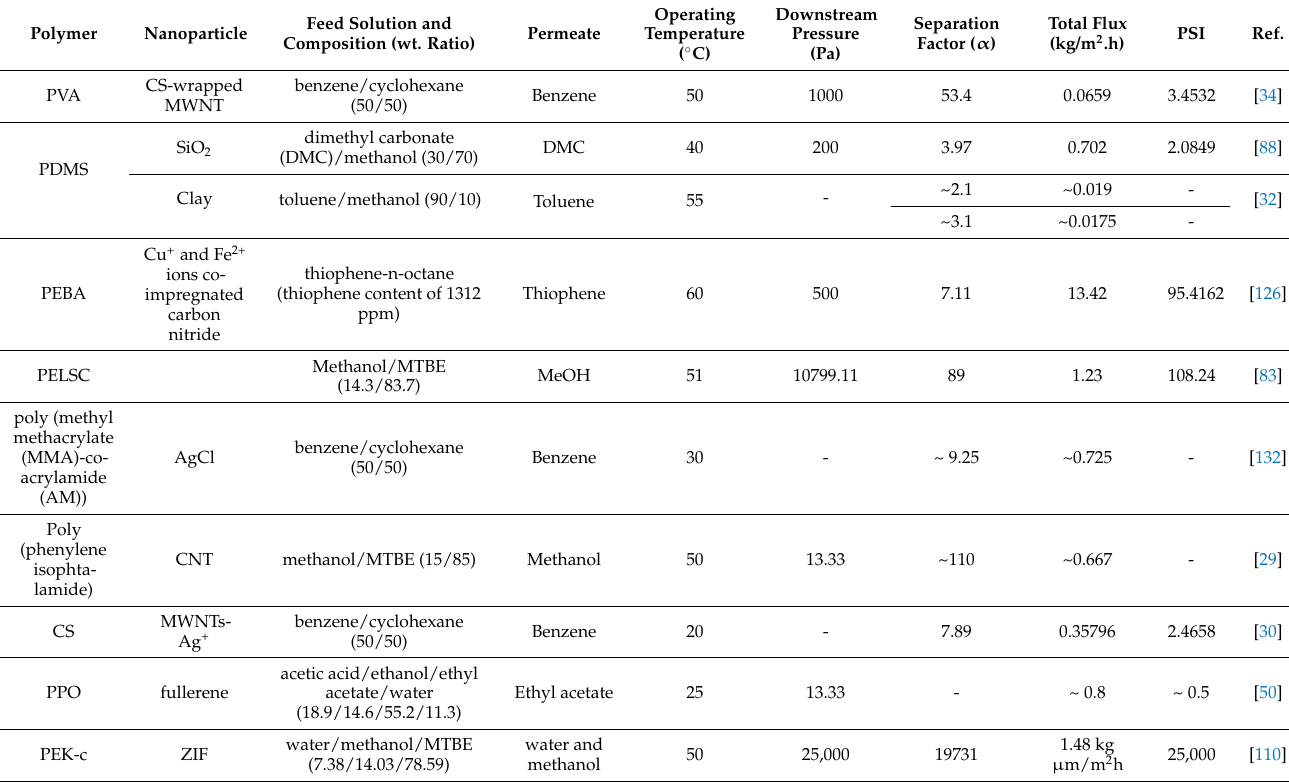
Table 9. PV performance of organophilic nanocomposite